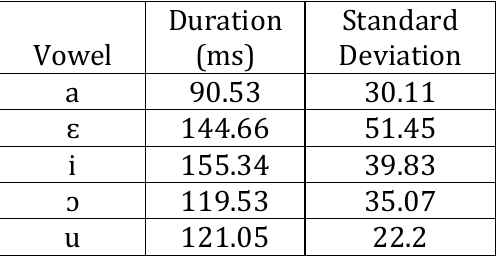
Table 5 : Duration and standard deviation values of all the vowels